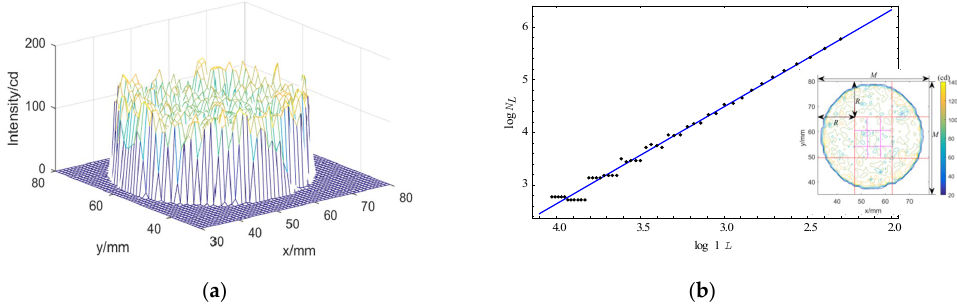
Figure 8. 3D intensity distribution law and method to determine fractal dimension. ( a ) 3D intensity distribution, ( b ) Computing method of fractal dimension.